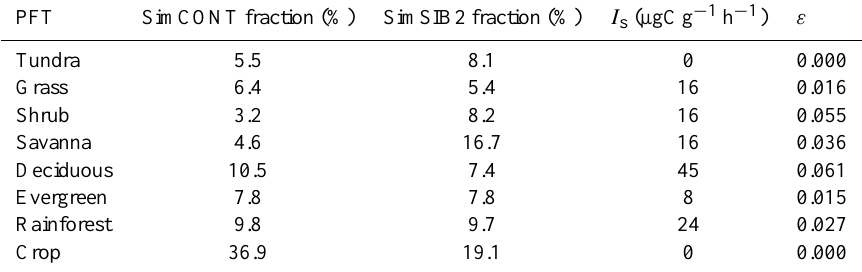
Table 1. PFT-specific fractional coverage of global vegetated land area in the standard and SiB2 data sets (%) and isoprene